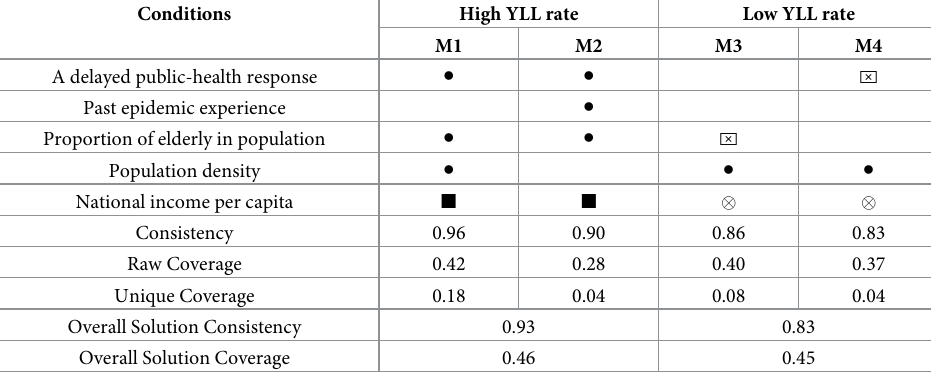
Table 5. Configurations of the subsample for high and low YLL rates.